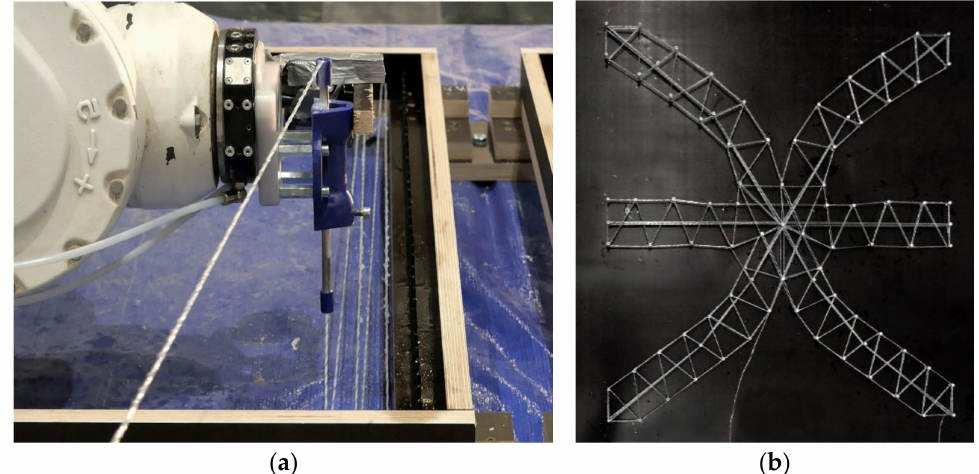
Figure 13. Dynamic fiber winding process for reinforcement: ( a ) winding principle around preplaced pins; ( b ) prefabricated fiber reinforcement inlay.